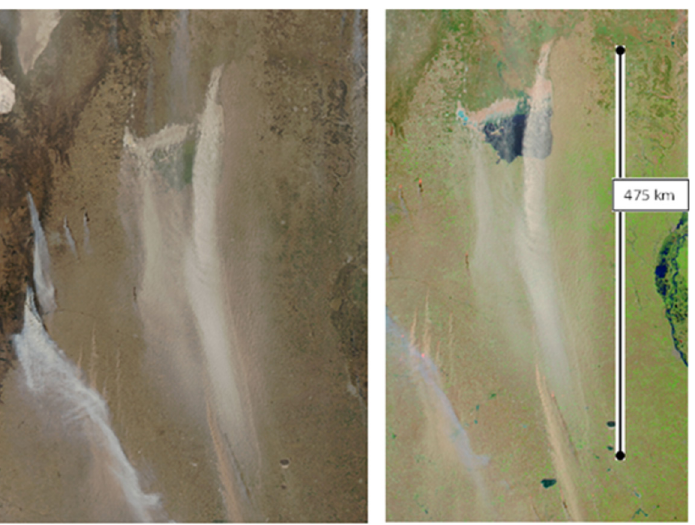
Fig 10. MODIS image of a salt dust event in Mar Chiquita on August 29, 2009. Left, true color, right, 721 bands. Image: MODIS AERONET Cordoba-CETT, aqua, 250 m pixel